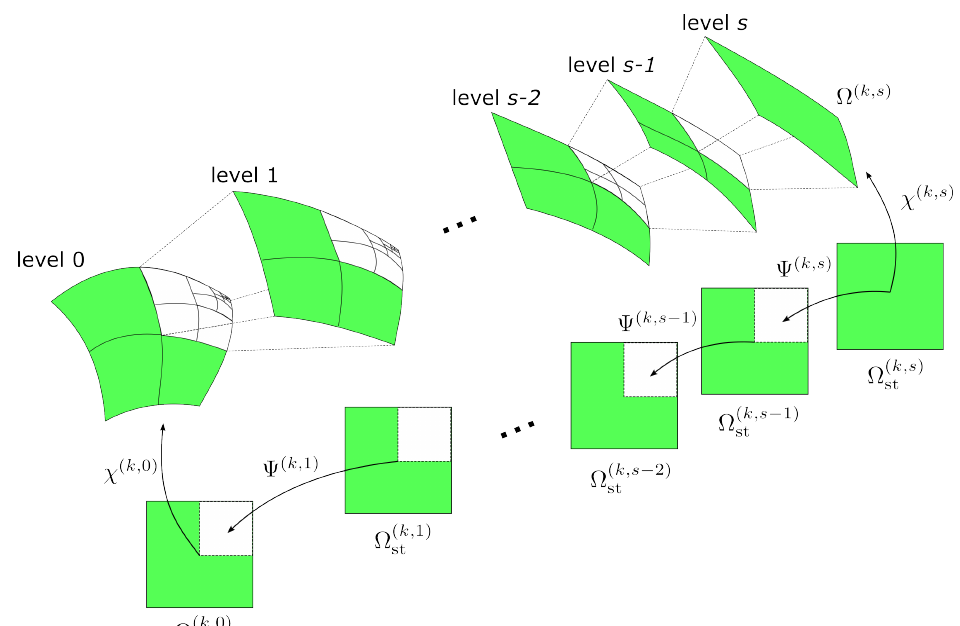
Figure 8. Mapping procedure between local meshes and global